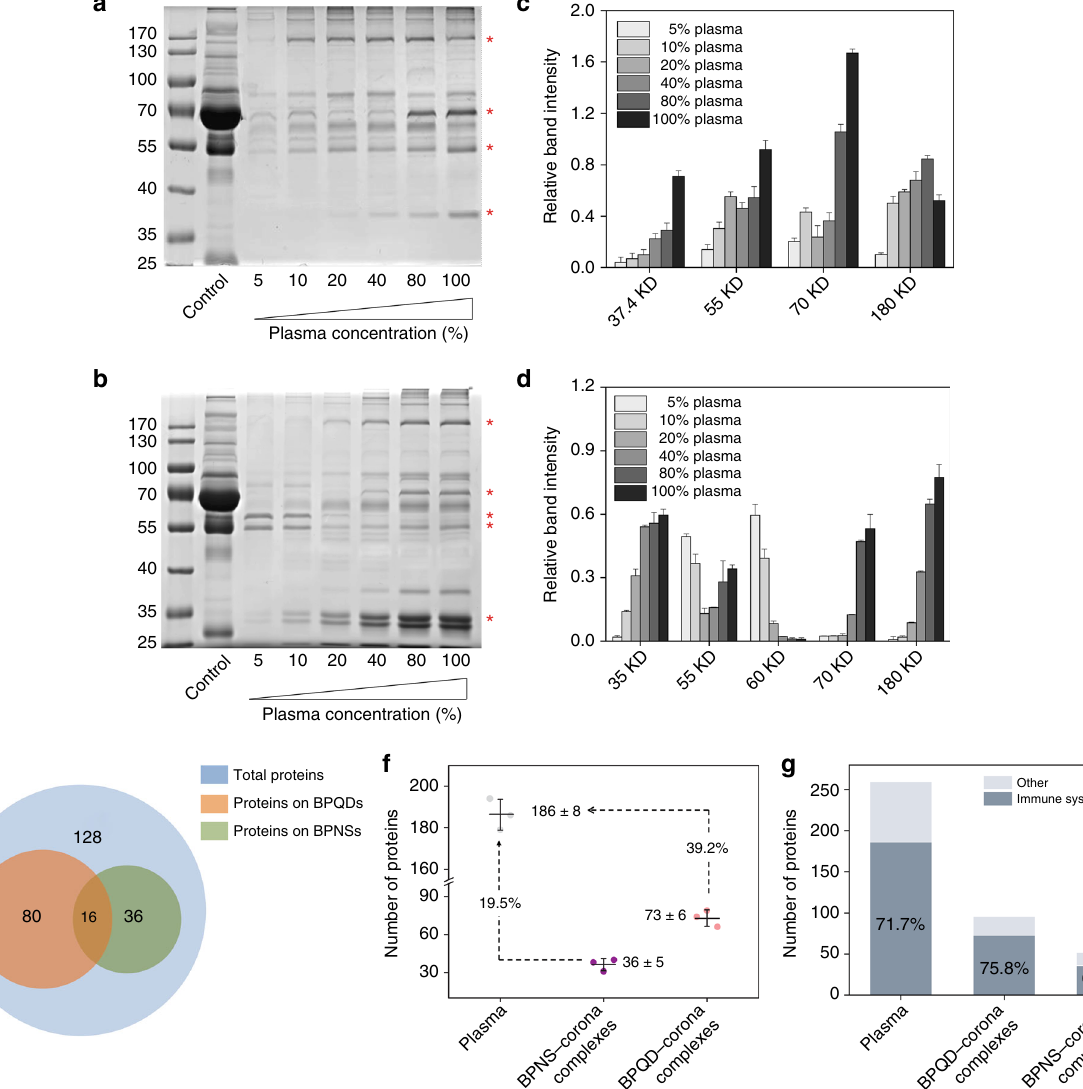
Fig. 3 Corona protein identi fi cation and classi fi cation. SDS-PAGE analysis of plasma protein obtained from a BPNS – corona complexes and b BPQD – corona complexes. The molecular weights of proteins in the standard ladder are reported on the left. Relative amounts of the most abundant proteins bound to c BPNSs and d BPQDs as calculated by the grey-scale value from the gels shown in a , b . Values are expressed as the means ± SDs of triplicates. e Statistical analysis of the total number of proteins identi fi ed by LC-MS/MS and f the number of proteins on BPQDs and BPNSs involved in immune system processes according to gene ontology (GO) analysis. Values are expressed as the means ± SDs of triplicates. g Analysis of the immune relevant protein